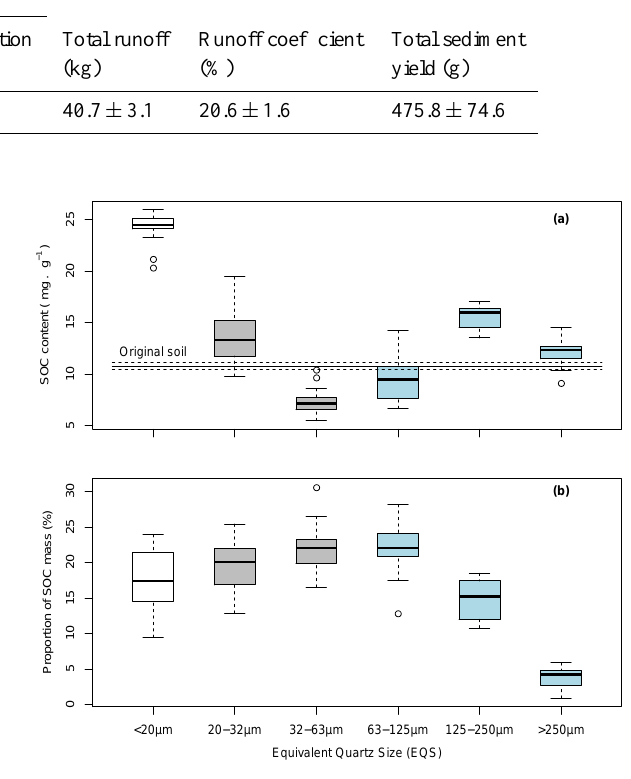
Figure 3. The distribution of soil organic carbon (SOC) content (a) , and soil organic carbon (SOC) mass (b) in different Equivalent Quartz Size (EQS) classes of the sediment. The bold and dashed lines in (a) denote the average and standard deviation of soil organic carbon (SOC) content of the original soil. Colors of the boxes corre- spond to the likely fate of each fraction after erosion. See Sect. 4.1